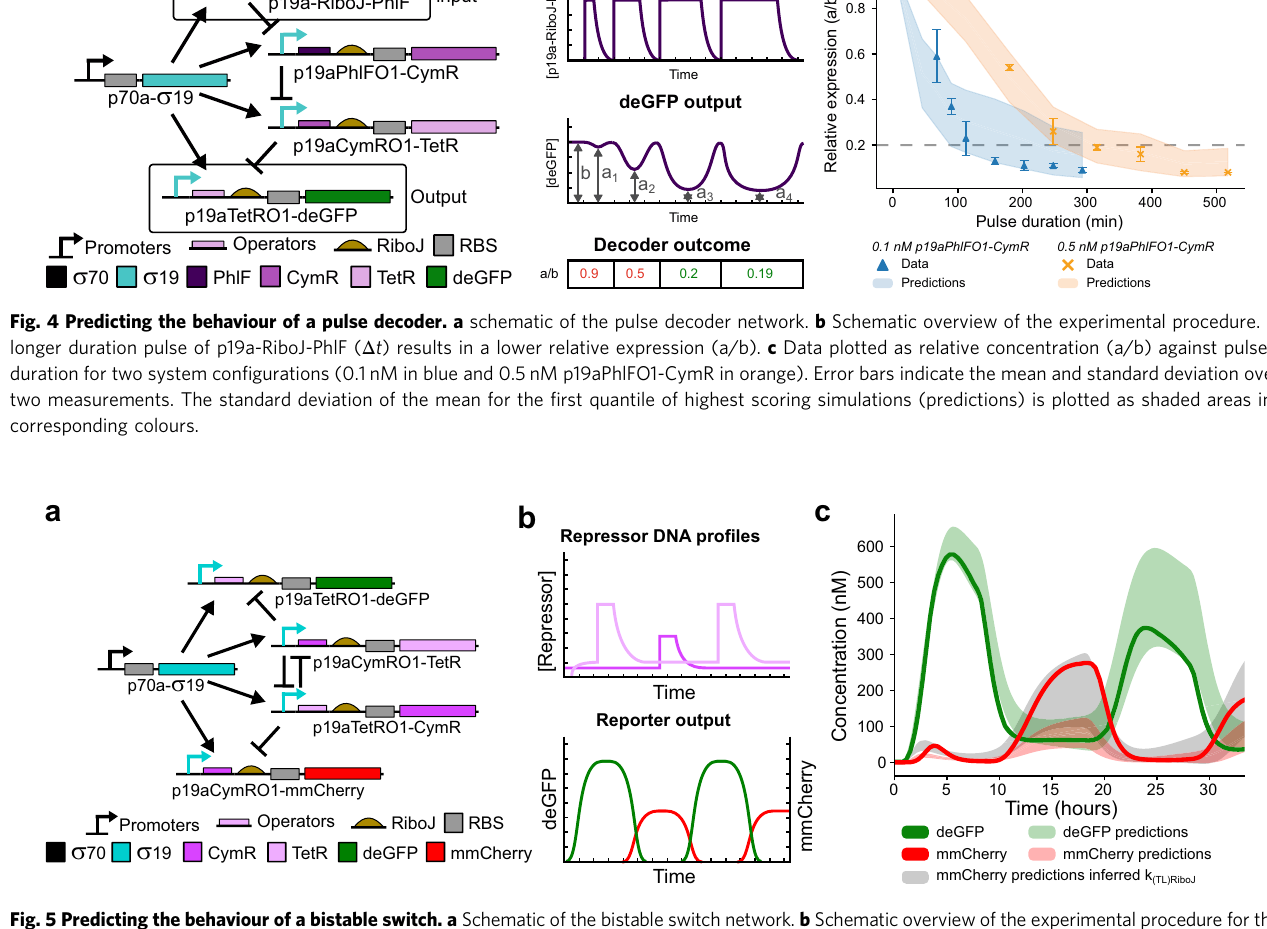
Fig. 5 Predicting the behaviour of a bistable switch. a Schematic of the bistable switch network. b Schematic overview of the experimental procedure for the triple switch experiment. The system starts in the CymR state resulting in deGFP expression. Short increases in either p19aCymRO1-TetR or p19aTetRO1- CymR concentration switch the system to the TetR or CymR state, respectively. c Triple switch experiment; experimental data (mean of three measurements) plotted as a solid line. The standard deviation of the mean for the fi rst quantile of highest scoring simulations (predictions) is plotted as shaded areas in corresponding colours. A prediction for the mmCherry signal using the same parameter sets but with an inferred k (TL)RiboJ is shown in